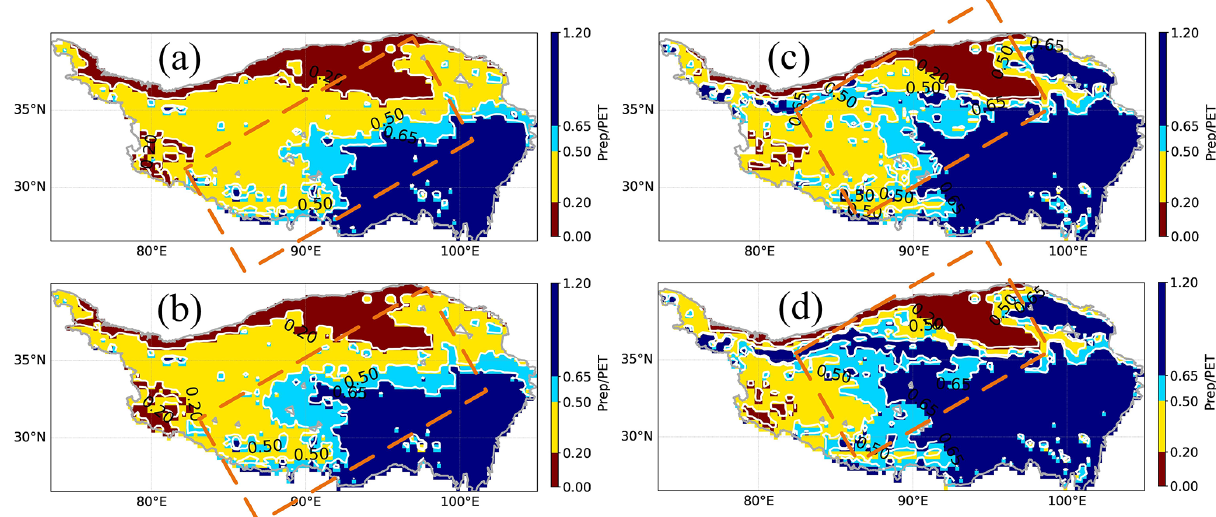
Figure 18. Multi-year average Prep/PET for the summer period of May–September over the stages of before (a,c) and after (b,d) the middle to late 1990s based on GLDAS and